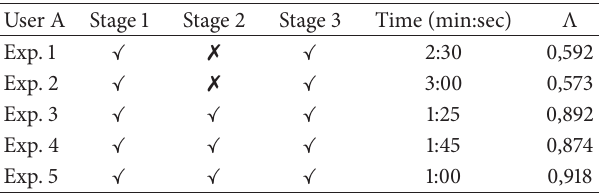
Table 1: Results of the experiment. User